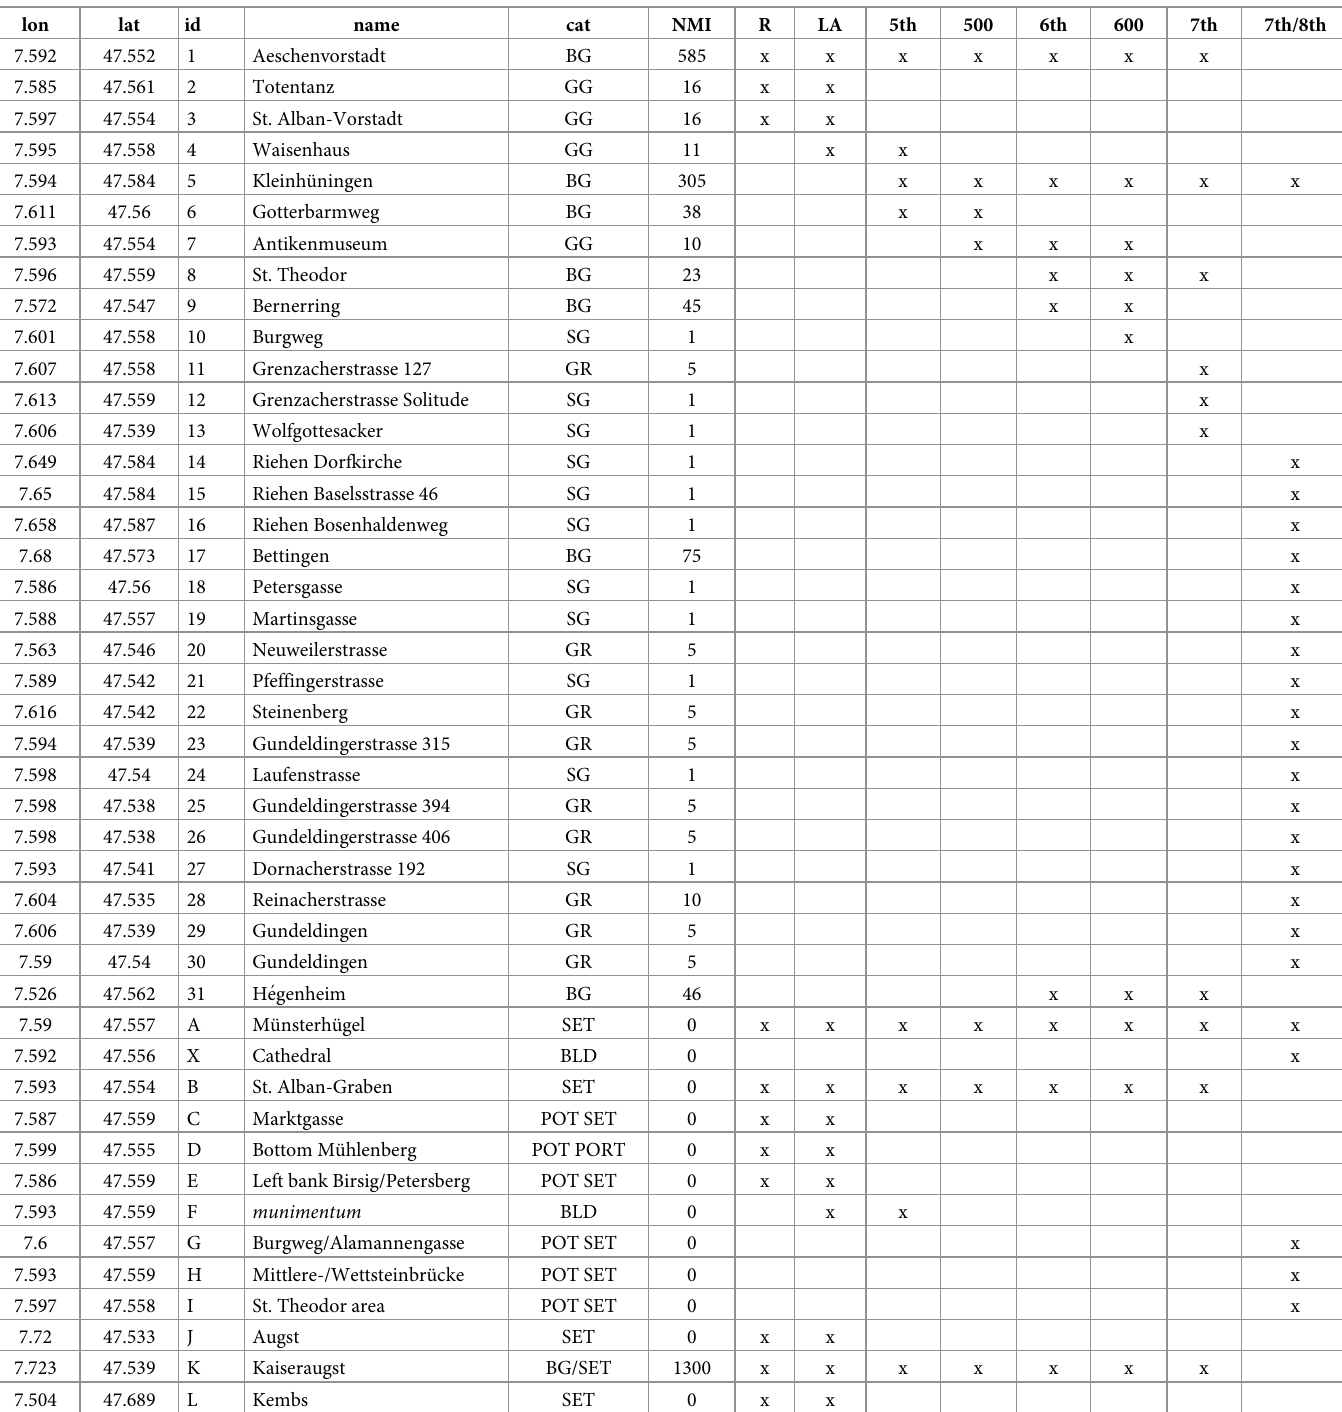
Table 1. Position, site id, label, name, type, and chronological occupation of the archaeological record discussed in this article (see Fig 1 for geographic